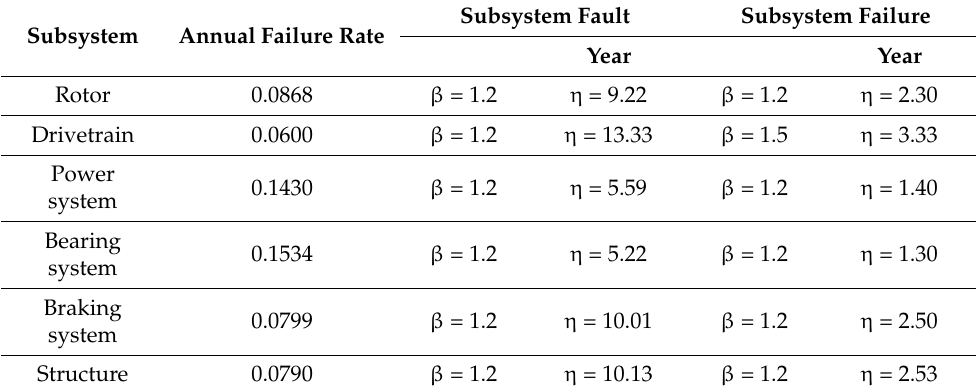
Table 1. Weibull distribution parameters for Transitions “W1” to